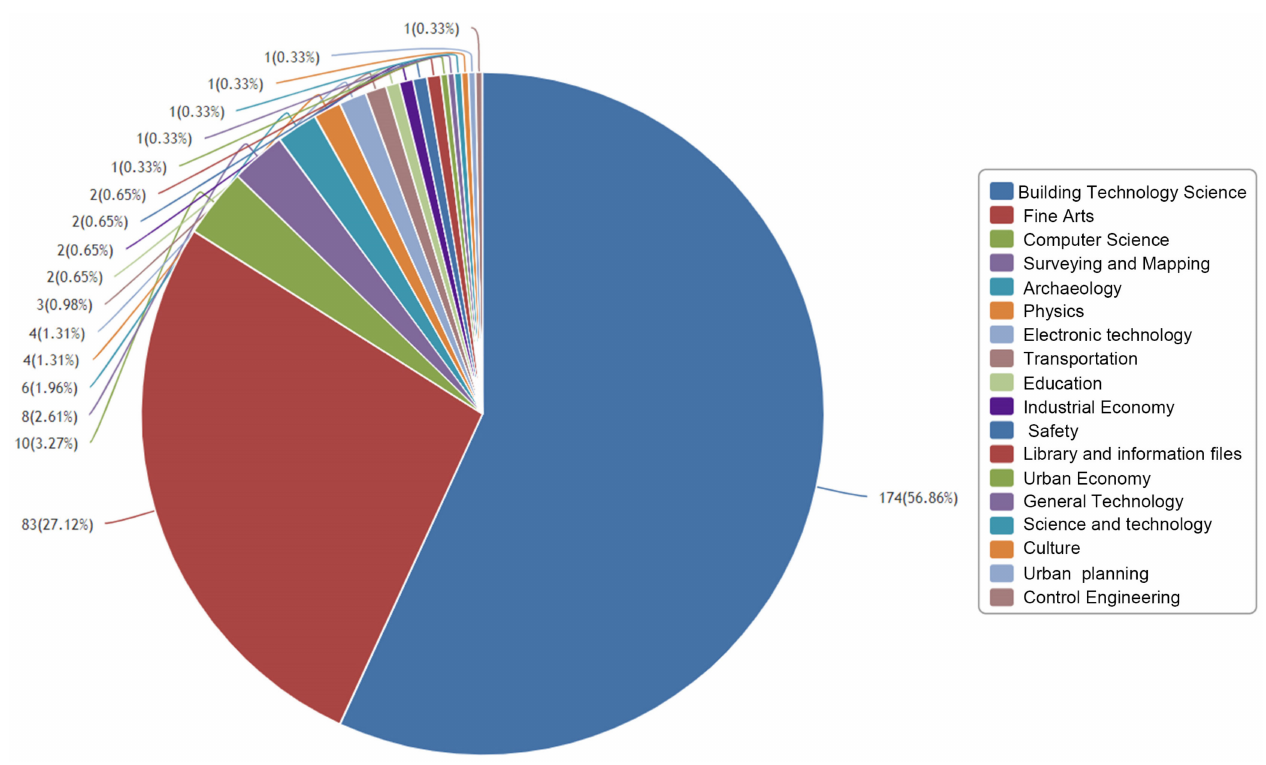
Figure 3. Distribution of the literature in subject areas involved in building information modeling (BIM) and architectural heritage research in China (186